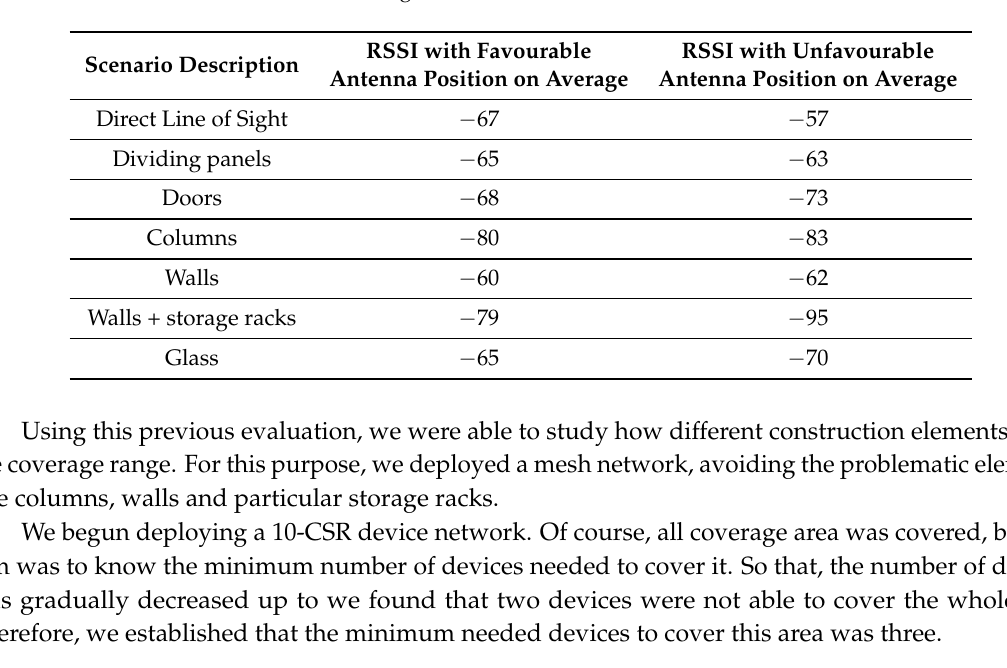
Table 2. Average RSSI obtained in different